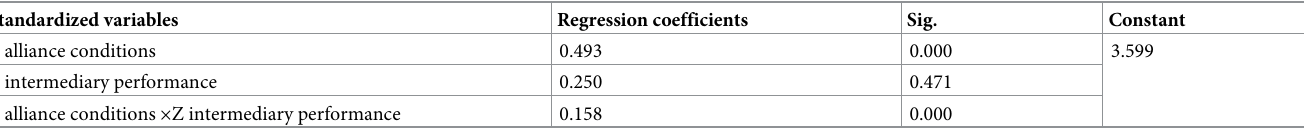
Table 3. Regression coefficients of alliance conditions and intermediary performance (The dependent variable: alliances performance).